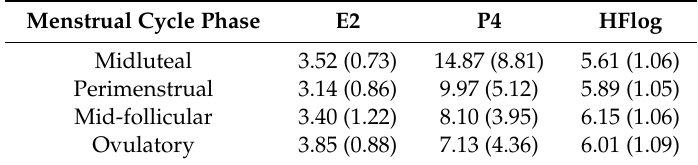
Table 1. Mean and Standard Deviation of Estradiol (E2), Progesterone (P4) and Log High Frequency Heart Rate Variability (HFlog) across the Menstrual Cycle Phases Investigated in Study One ( N = 105 visits).